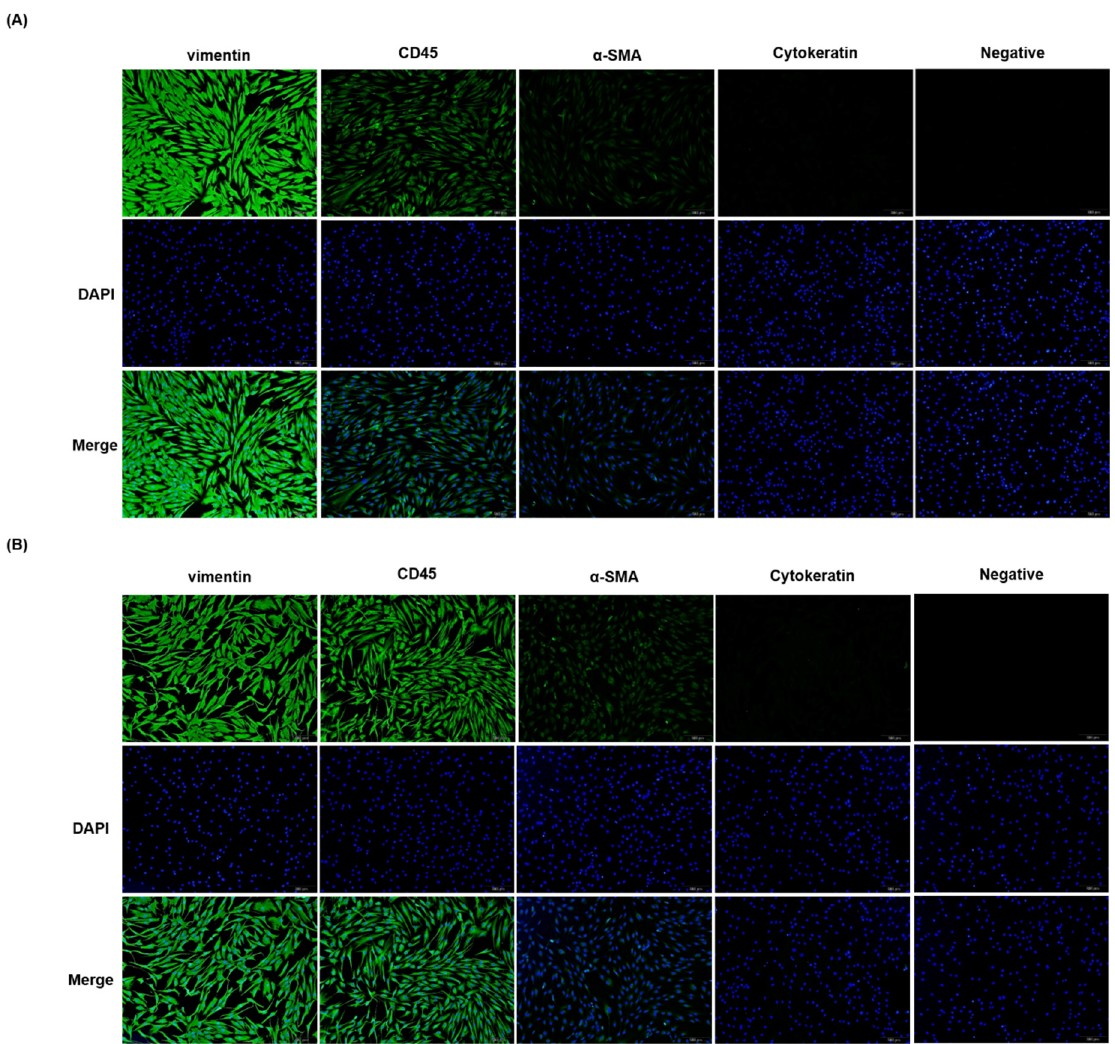
Figure 1. Characterization of orbital fibroblasts isolated from TED patients and control. Orbital fibroblasts were obtained from fat tissue of TED ( − ) patients ( A ) and TED (+) patients ( B ). Morphology was examined by phase contrast microscopy and the expression patterns for vimentin (VIM), CD45, α -smooth muscle actin ( α -SMA), and cytokeratin respectively were examined by immunofluorescence staining in the fibroblast and non-fibroblast. Magnification × 100.